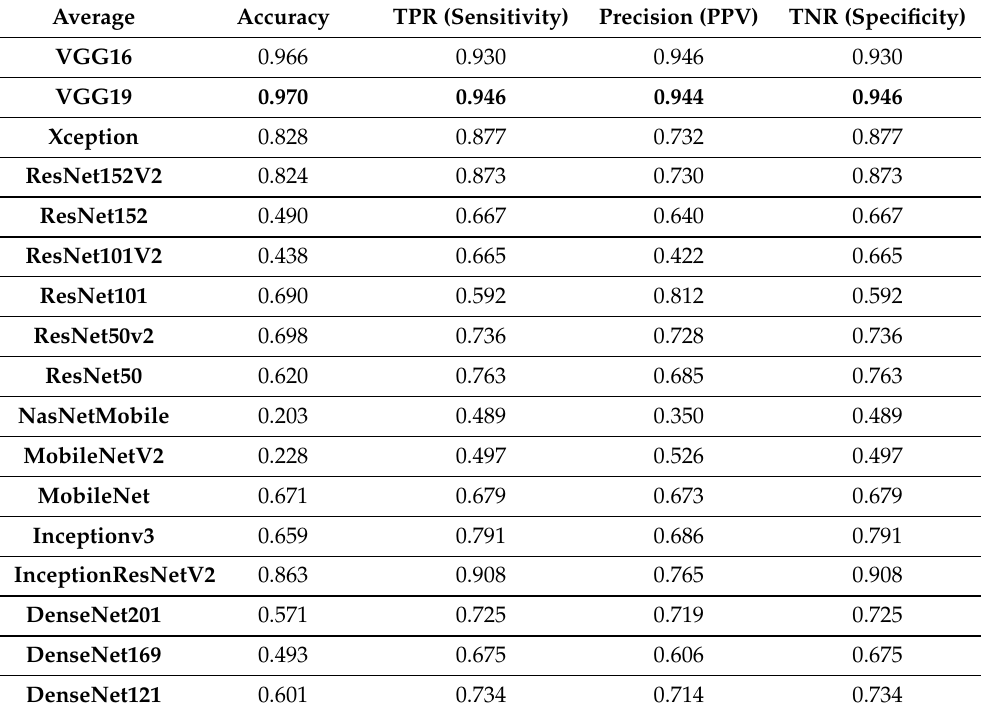
Table 3. Average metric results related to KDE (duration = 20 s normal, duration = 35 s abnor- mal) datasets.